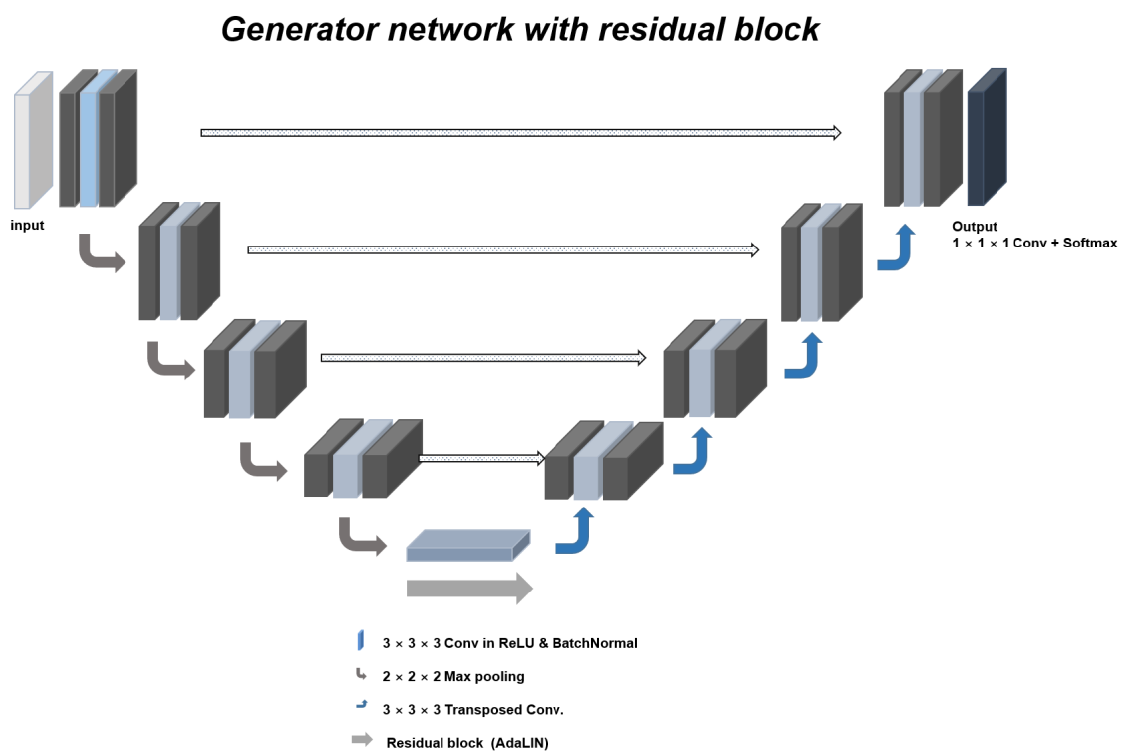
Figure 2. Model architecture of the image generator including residual blocks for upsampling. This network has a ResNet structure. The AdaLin includes fully connected layers and LeakyReLu activation layers. ResNet, residual neural network; AdaLin, adaptive layer-instance normalization; LeakyReLu, leaky rectified linear unit.